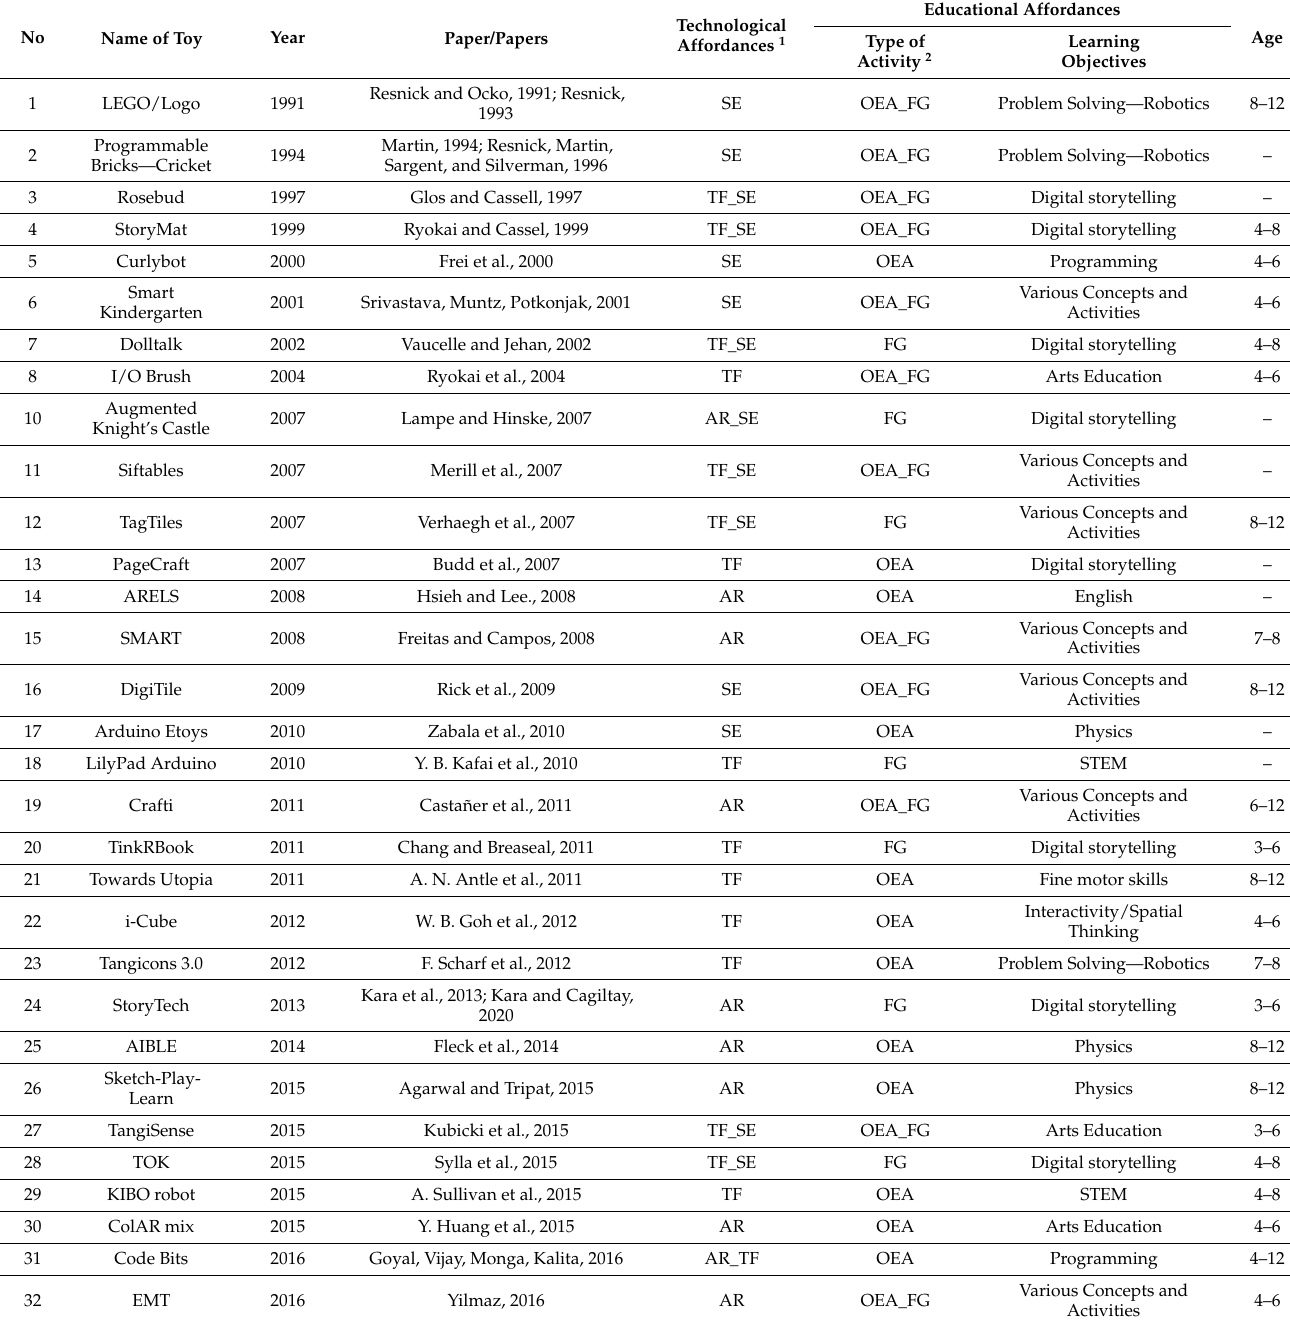
Table 2. Classification of Smart